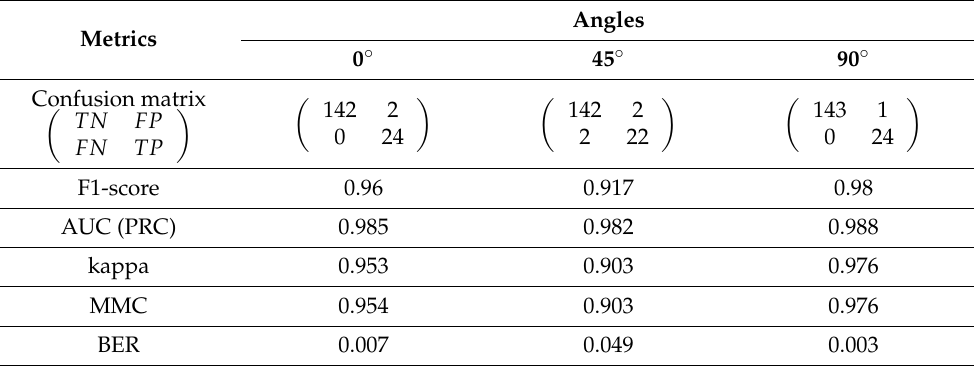
Table 5. Statistical results from the RGB data of the 12-participant group for three angles between the longitudinal axis of the body and the cameras. Angles Metrics 0